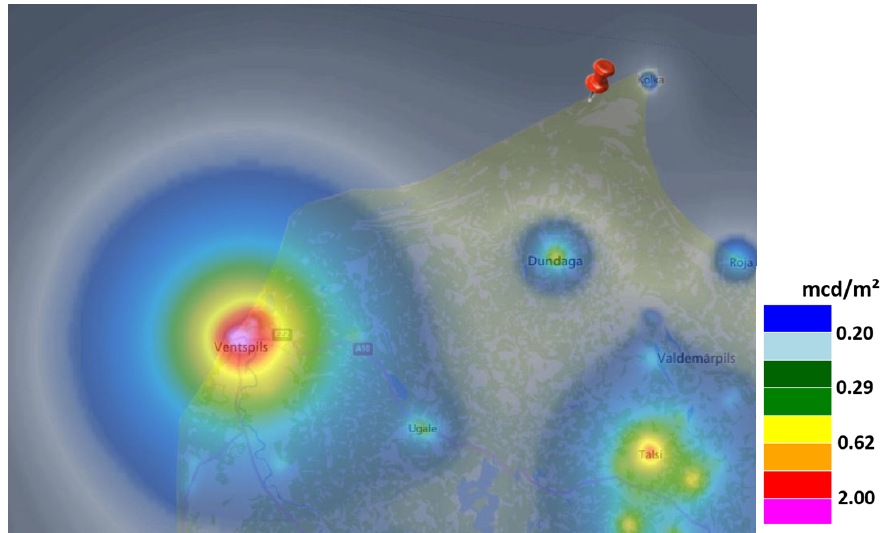
Figure 3. Map of the remote site in Saunags, Latvia (arrow) near the village Kolka, Latvia, on the Courland peninsula using data from the world atlas of artificial night sky brightness [1] (source: lightpollutionmap.info by Jurij Stare).